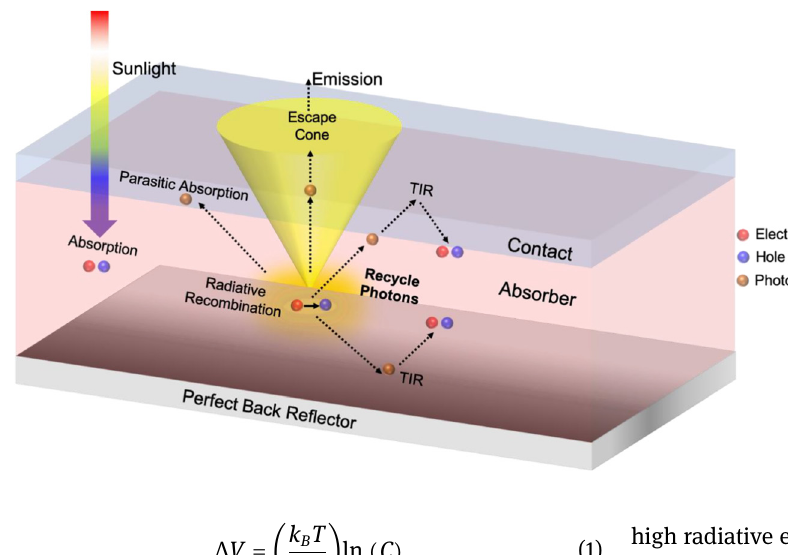
Figure 1: Schematic design of photon recycling under thermal equilibrium in a semiconductor slab. Following radiative recombination, photon recycling may occur due to direct reabsorption or